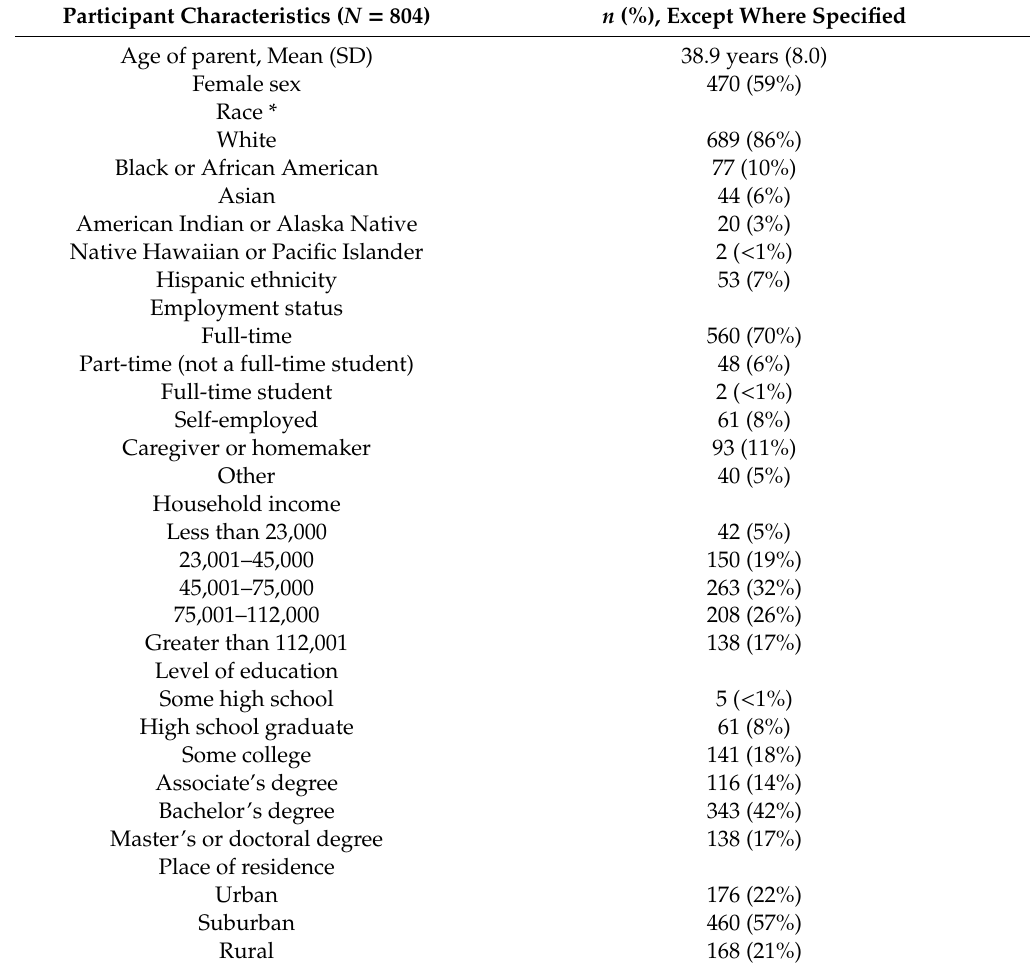
Table 2. Participant